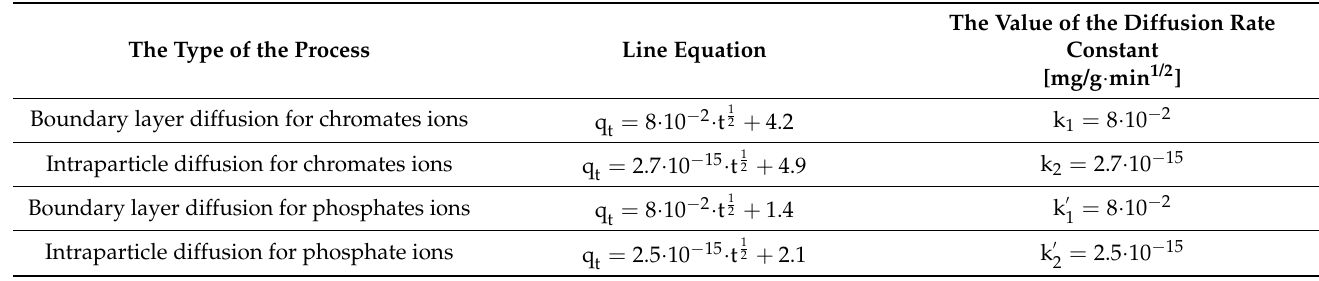
Table 10. Values of the diffusion rate constants of the phosphates and chromates adsorption